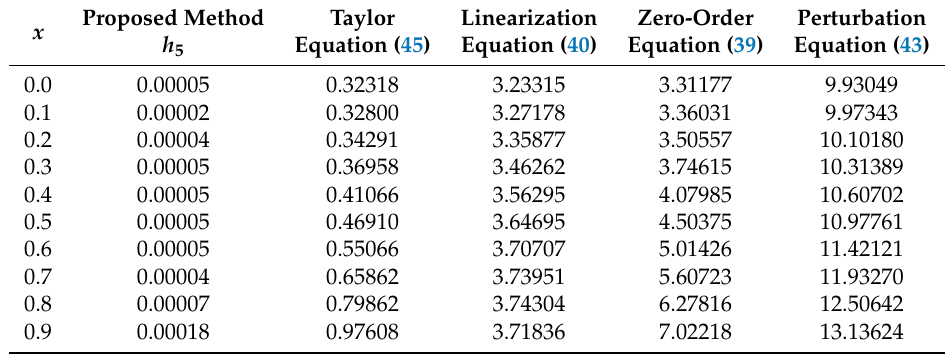
Table 1. Comparison of relative errors obtained by different numerical schemes for problem (2) with parameters a = b =